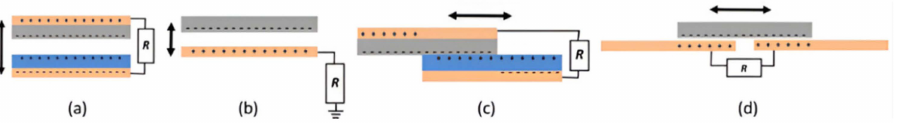
Figure 2. TENG modes: ( a ) vertical contact-separation mode, ( b ) single-electrode mode, ( c ) lateral- sliding mode, and ( d ) freestanding triboelectric-layer